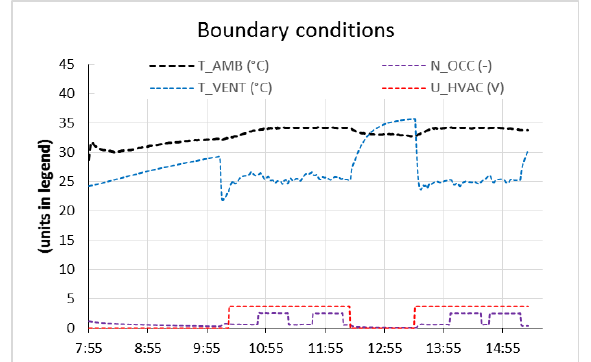
Fig. 4. Summer test for test subject. Boundary conditions.